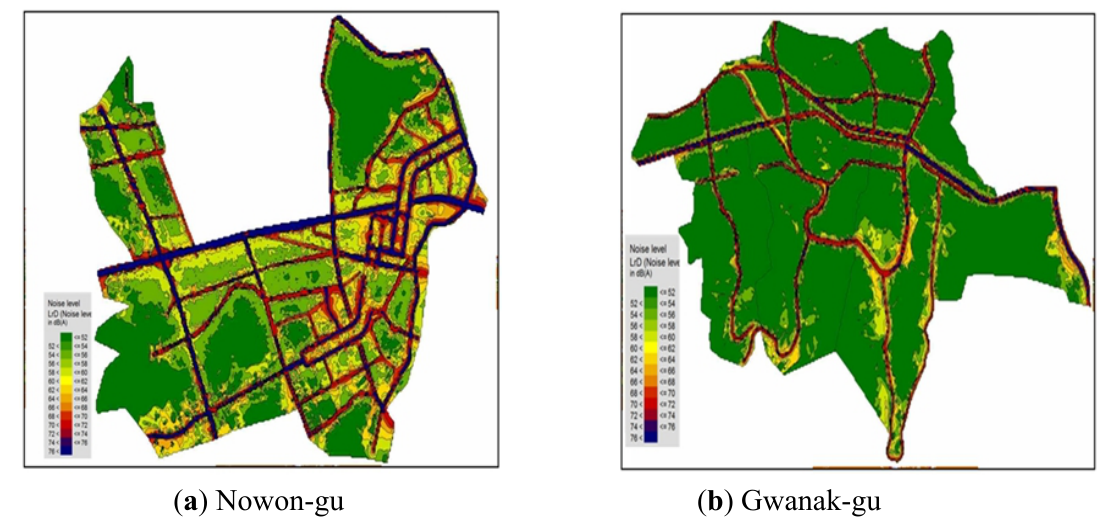
Figure 5. Grid noise maps of two districts (“whole” gu).